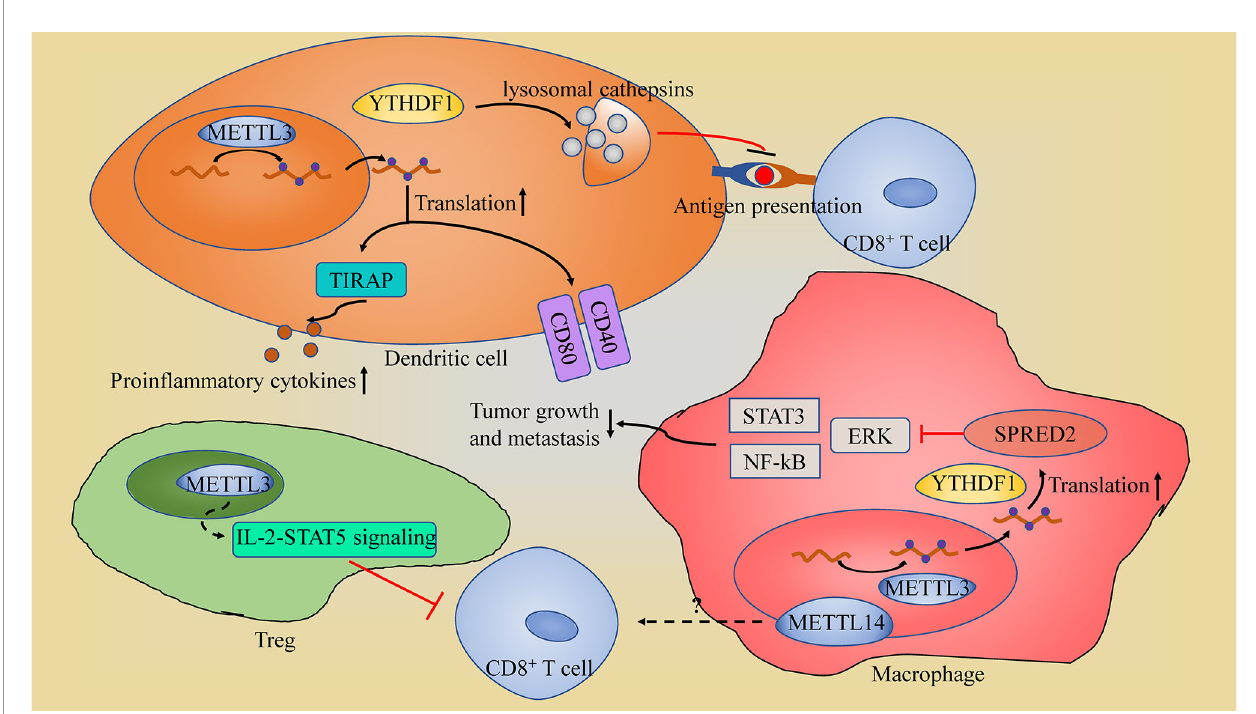
FIGURE 3 | The schematic of m 6 A in immune cell. (1) In dendritic cells (DCs), YTHDF1 suppresses the antigen-presentation by DCs through maintain the expression of lysosomal cathepsins; METTL3-mediated m6A modi fi cation promotes DCs activation through enhancing the translation ef fi ciency of CD40, CD80 and TIRAP. (2) METTL3 in Tregs sustains the suppression roles of regulatory T cells through IL-2-STAT5 signaling pathway impairing CD8+ T cells tumor killing ability. (3) In macrophages, METTL3 sustains the YTHDF1-mediated translation of SPRED2, which inhibits NF-kB and STAT3 through the ERK pathway, restricting tumor growth and metastasis; METTL14-de fi ciency in macrophage impairs CD8+ T cells to eliminate